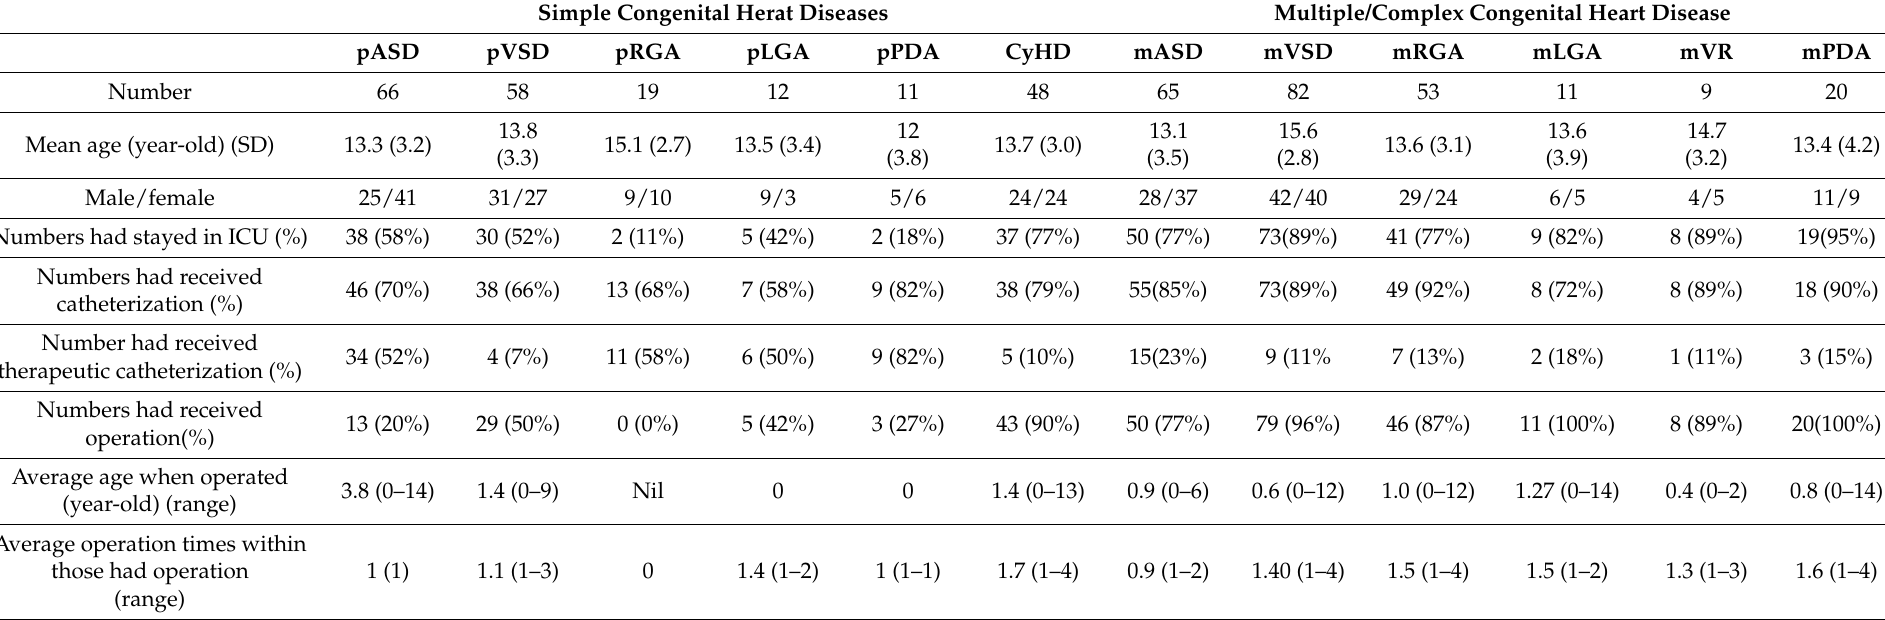
Table 1. Demographic data of children and adolescents with congenital heart disease. Simple Congenital Herat Diseases